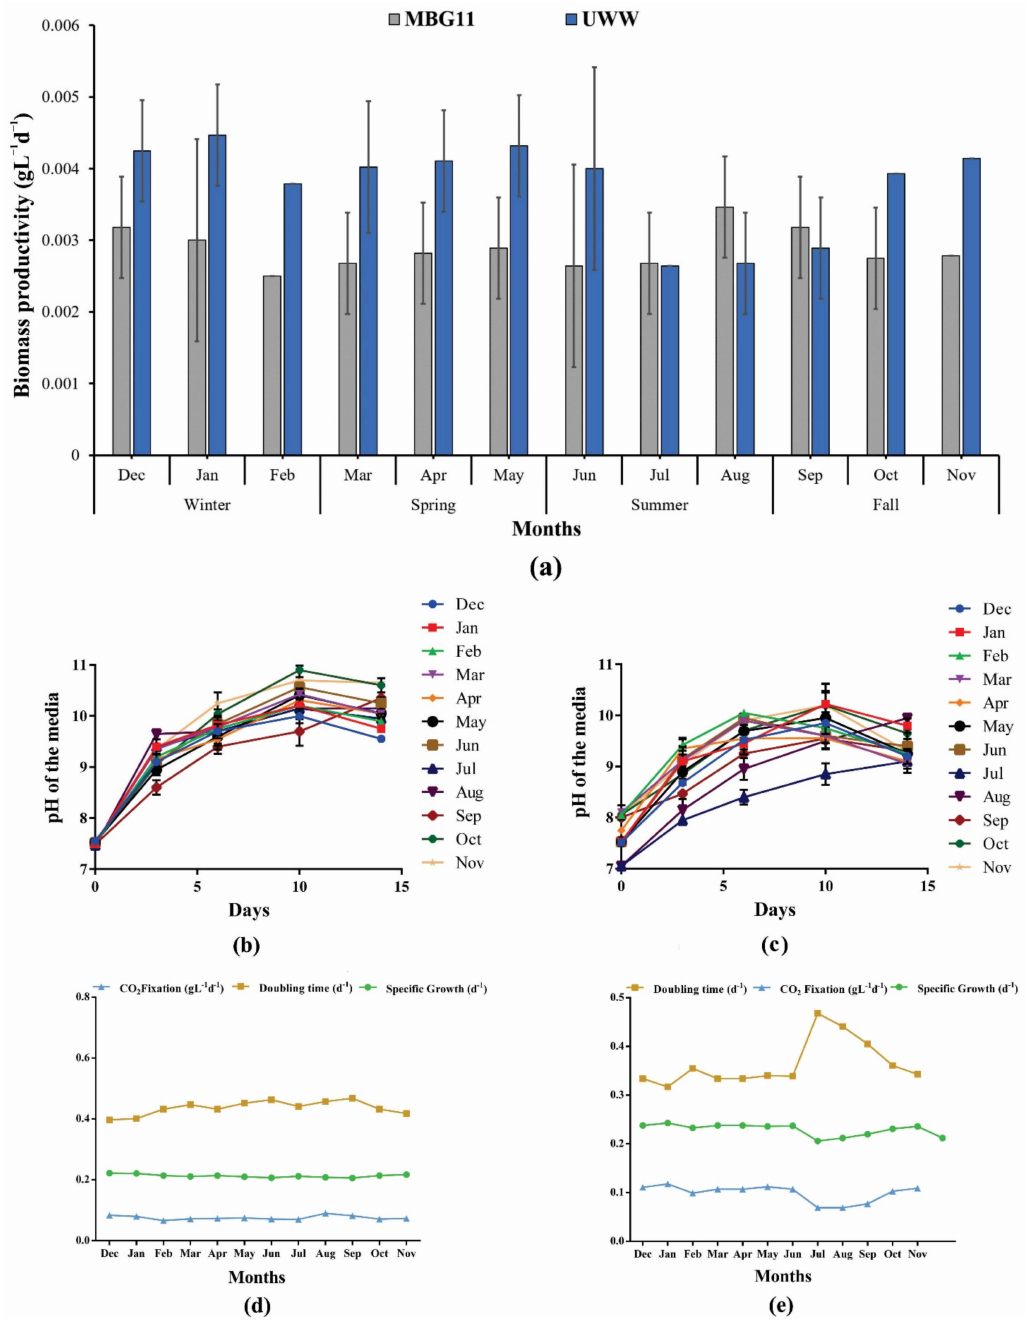
Figure 1. Biomass productivity in response to different growth conditions, its growth kinetics, and pH variation trend: ( a ) biomass productivity by P. terebrans BERC10 in urban wastewater (UWW) and MBG11; ( b ) variation in pH in response to MBG11 cultivation; ( c ) variation in pH in response to UWW cultivation. Relationship of CO 2 fixation, doubling time, and specific growth when the strain was cultured in ( d ) MBG11 media; ( e ) urban